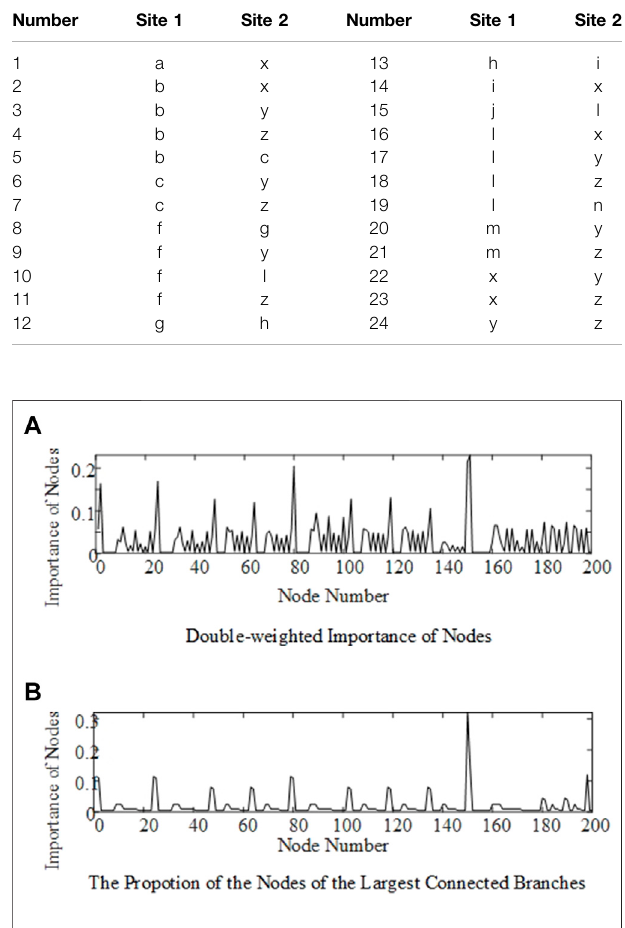
FIGURE 6 | Importance of nodes. (A) is double-weighted importance of nodes (B) is the propotion of the nodes of the largest connected